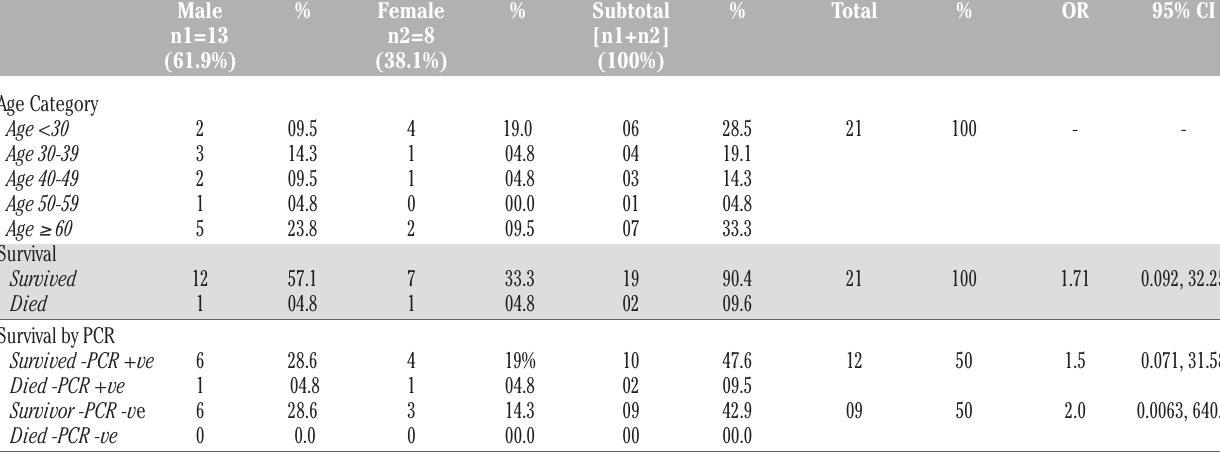
Table 2. Distribution of outbreak patients by main study variables by gender (n=21). Male % Female